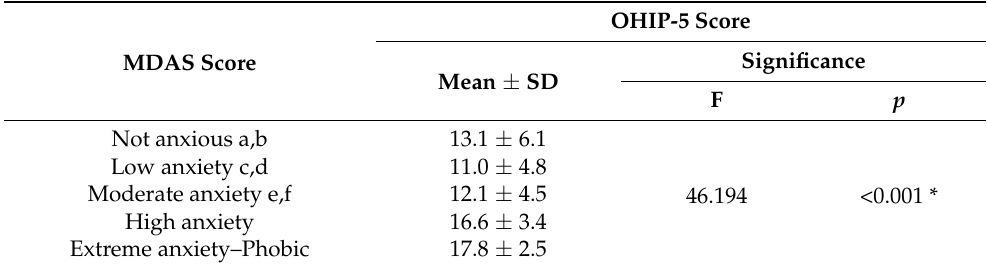
Table 5. The mean score and post-hoc analysis of OHIP-5 by dental anxiety